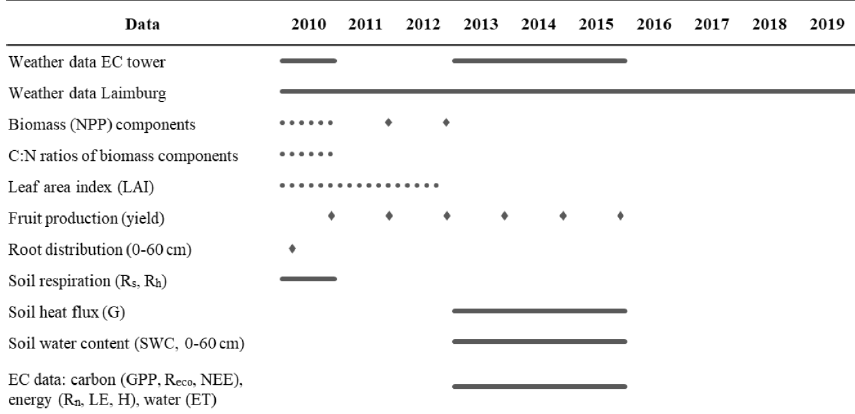
Table 1. Summary of available data from an apple orchard in the Adige River valley, South Tyrol, Italy, between 2010 and 2019. Solid lines represent continuous and dotted lines monthly measurements, while diamonds represent single